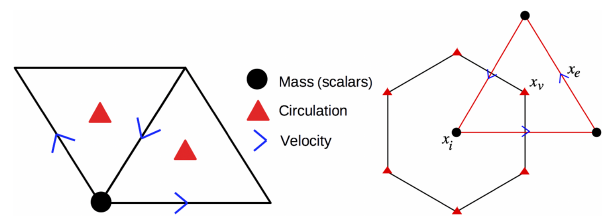
Figure 1. Left: basic computational cell for the icosahedral C-grid discretization, containing one node (for mass and buoyancy), three edges (for velocities) and two triangles (for circulation). Right: rela- tion of the triangular (primal) and hexagonal (dual) cells. Note that the cells are not regular polygons on the sphere and there are 12 exceptional pentagonal dual cells. Separate wavelet transforms are provided for the nodes (scalar-valued) and edges (vector-valued). The adaptive grid consists of the significant nodes and edges, to- gether with nearest neighbours in position and scale necessary for dynamics. The horizontal grid is the same in each vertical